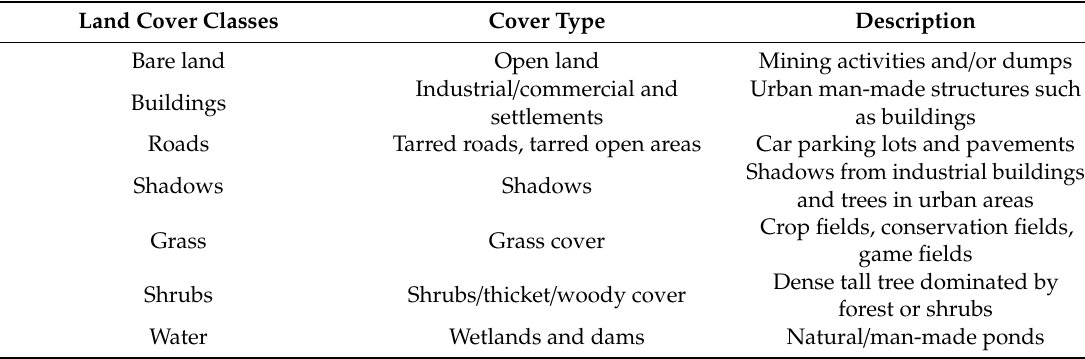
Table 2. Land cover classes and their